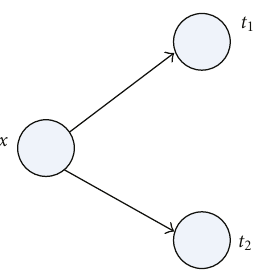
Figure 1: Probabilistic graphical model for